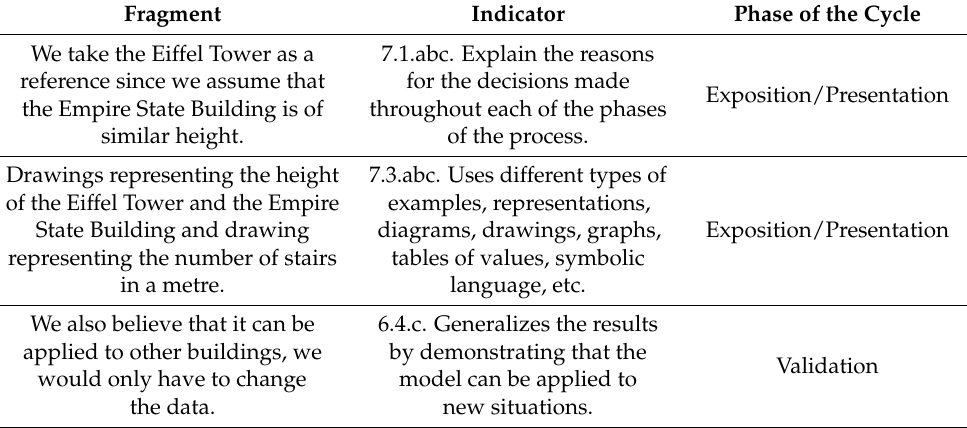
Table 11. Extract from the analysis of the modelling phases presented in the chart with the REPMM